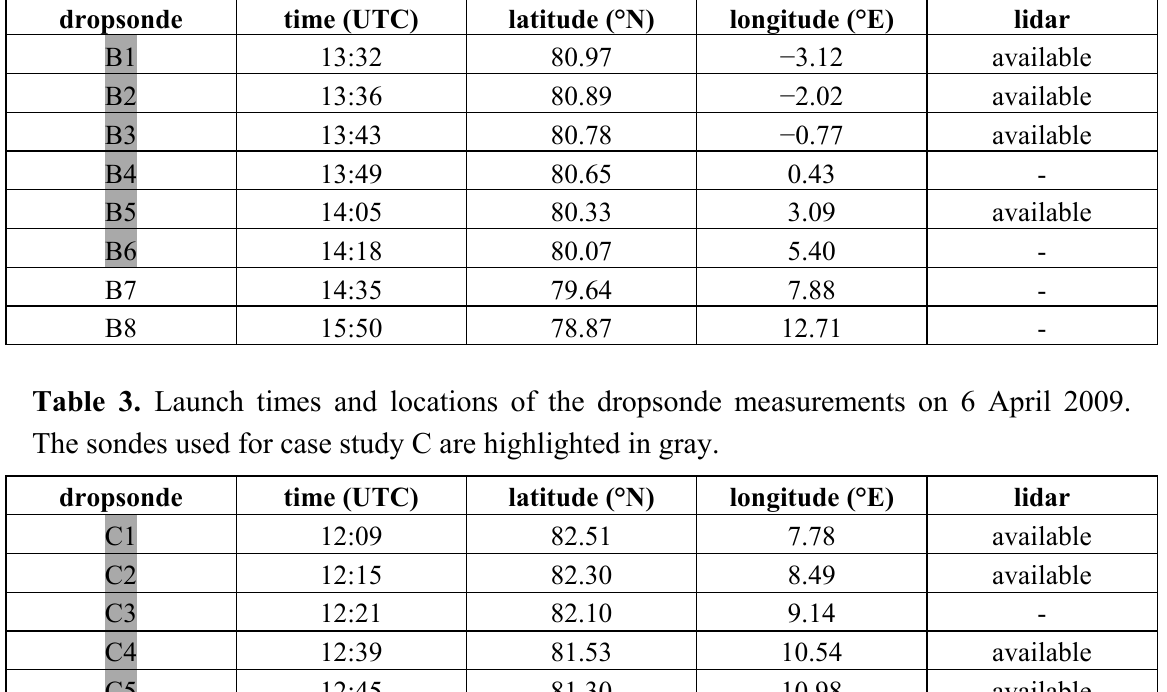
Table 2. Launch times and locations of the dropsonde measurements on 5 April 2009. The sondes used for case study B are highlighted in gray. dropsonde